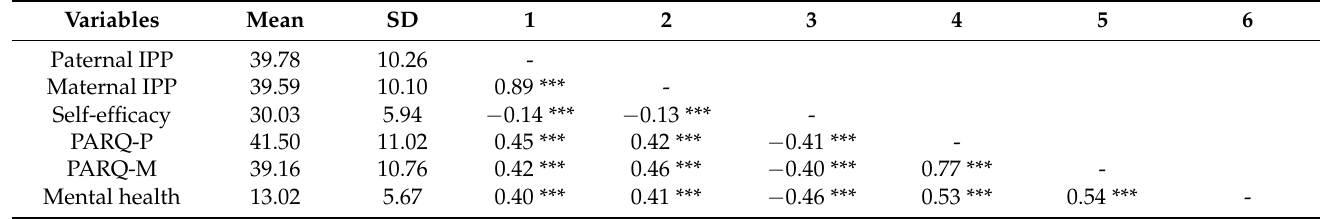
Table 2. Means, standard deviations, and correlations between the variables of the study.